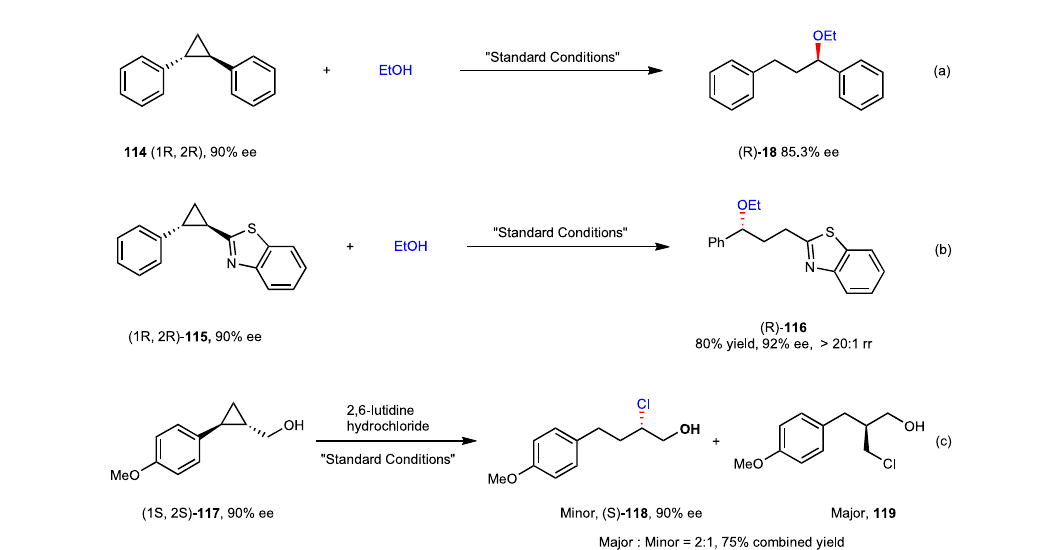
Fig. 7 | Stereospeci fi c reaction with enantioenriched substrates. a Reaction of enantioenriched trans-1,2-diphenyl cyclopropane 114 with ethanol. b Reaction of enantioenriched 1,2-di(hetero)aryl cyclopropane 115 with ethanol. c Reaction of enantioenriched 1-aryl-cyclopropyl-carbinol 117 with 2,6-lutidine hydrochloride.